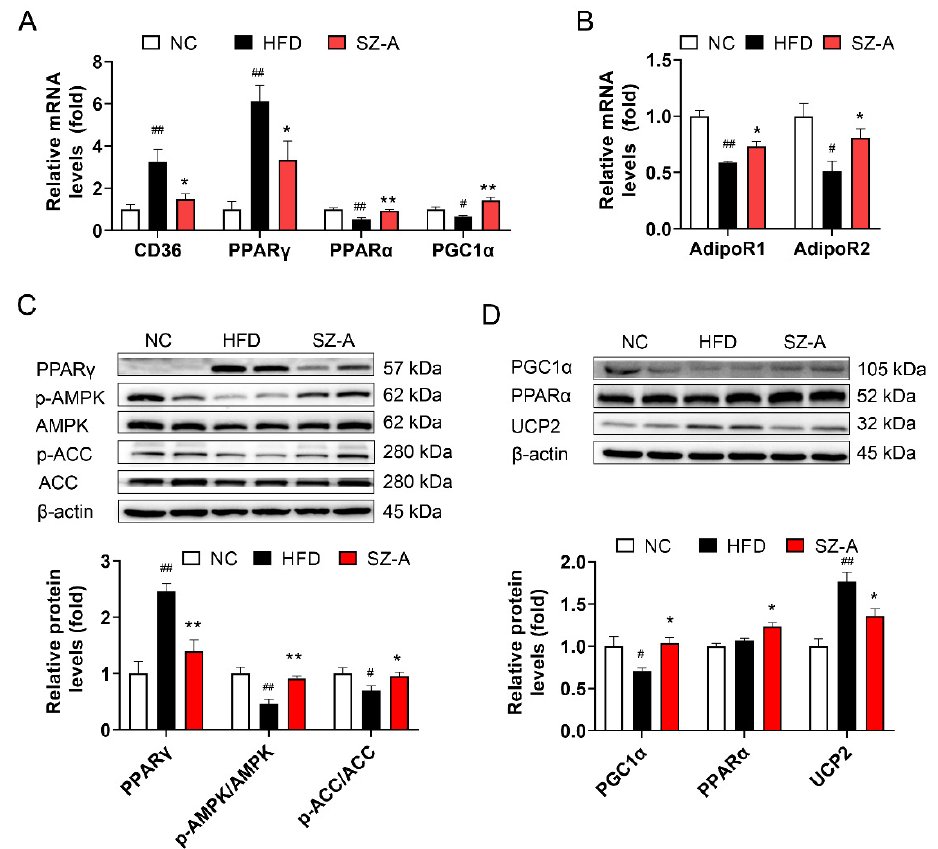
Figure 7. SZ-A regulates lipid metabolism and oxidative stress. ( A , B ) Relative mRNA expression levels of genes, including CD36, PPARγ, PPARα, PGC1α, AdipoR1, and AdipoR2. ( C , D ) Hepatic levels of genes, including CD36, PPAR γ , PPAR α , PGC1 α , AdipoR1, and AdipoR2. ( C , D ) PPARγ, p-AMPK, p-ACC, PGC1α, PPARα, and UCP2 protein expression were detected by Western blot with specific antibodies. Data are represented as mean ± SEM ( n = 6/group). # p < 0.05, ## p < 0.01 compared with the NC mice (i.g.), and * p < 0.05, ** p < 0.01 compared with the HFD mice (i.g.).